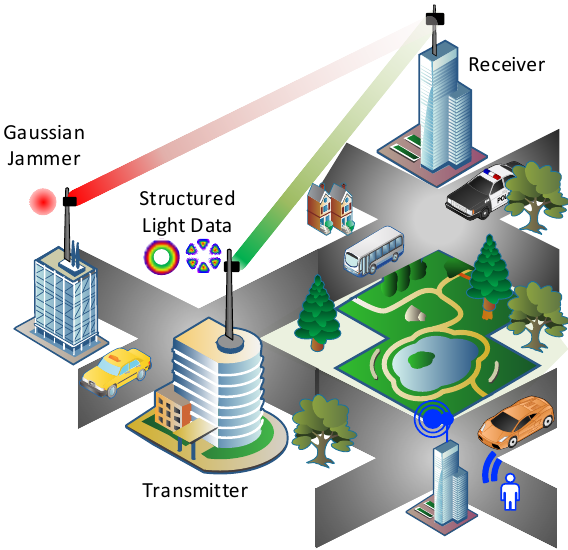
Figure 1. Structured light communication patterns between buildings with extrinsic Gaussian profile